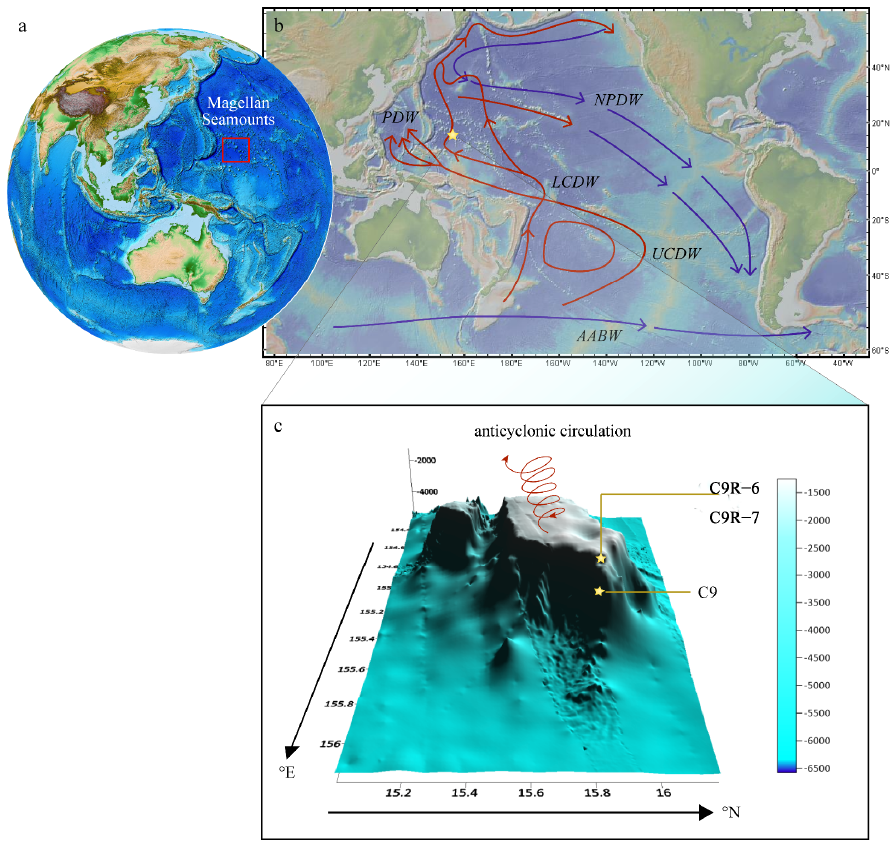
Figure 1. ( a ) The location of the study area. ( b ) The location of the study area and the modern Pacific Ocean circulation system, the yellow star represents Caiwei Guyot. The red and blue lines represent the lower circumpolar deep water (LCDW), the upper circumpolar deep water (UCDW), the Pacific deep water (PDW), the north Pacific deep water (NPDW), and the Antarctic bottom water (AABW) (modified by [30]). ( c ) Topographic map of Caiwei Guyot (data are quoted from https://www.gebco.net on 15 July 2022), the yellow star represents HOBAB5-C9, HOBAB5-C9R-6, HOBAB5-C9R-7 the red line represents clockwise anticyclone circulation (Taylor Column). Caiwei Guyot is located in the Magellan seamounts of the eastern Mariana Basin by CDW (circumpolar deep water) and AABW (Antarctic bottom water) in the Southern Ocean [30]. CDW can be divided into upper circumpolar deep water (UCDW) with maxi- mum temperature and lower circumpolar deep water (LCDW) with maximum salinity